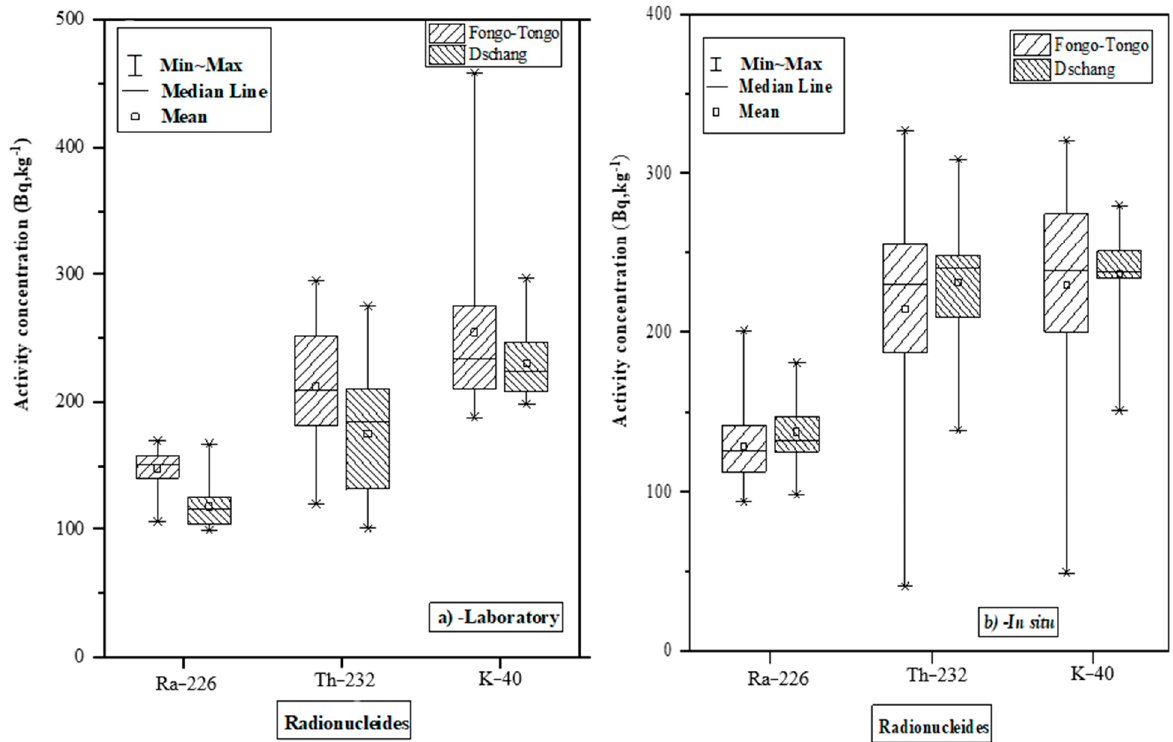
Figure 2. Boxplot distribution of activity concentration of 226 Ra, 232 Th, and 40 K obtained by laboratory ( a ) and in situ ( b )